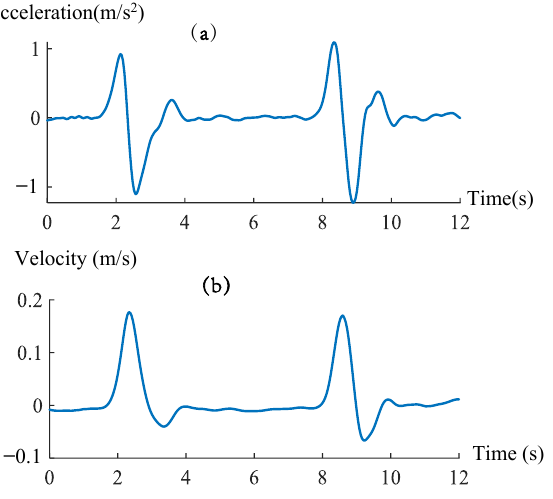
Figure 7. The vehicle moving process. ( a ) Vehicle acceleration. ( b ) Vehicle velocity.